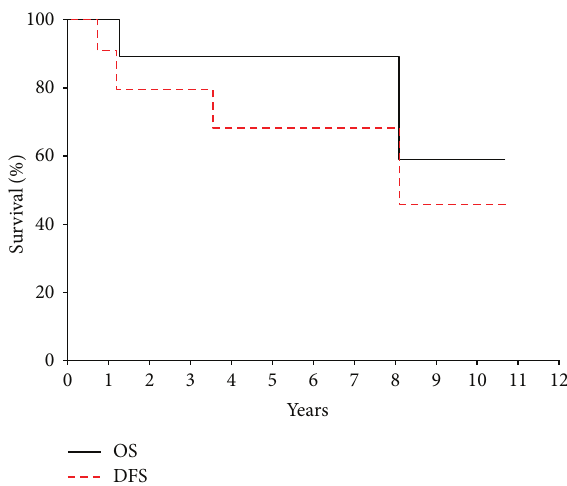
Figure 1: Overall survival (OS) and disease-free survival (DFS) for all patients with mesenchymal chondrosarcoma.